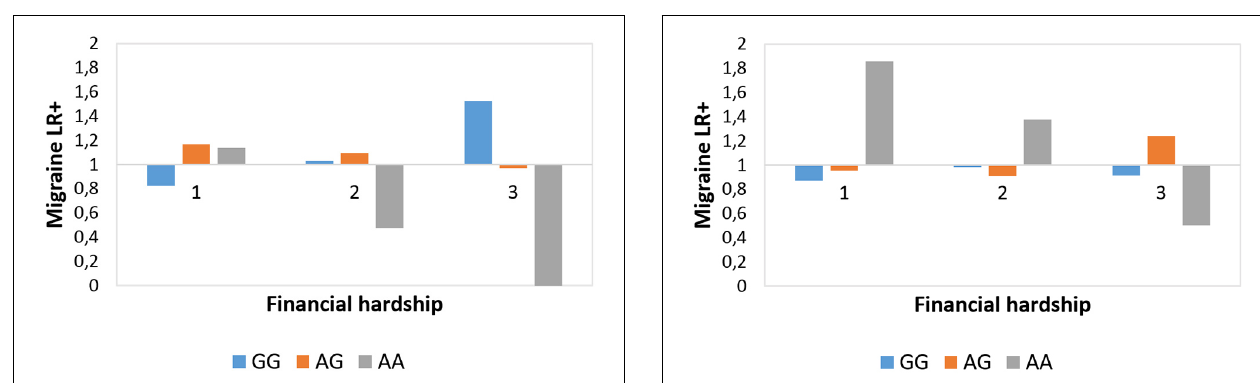
Table 3 shows the statistical results of interaction effects between CLOCK rs10462028 and financial hardship on migraineID in the subsamples separately (Manchester and Budapest)—to test the replicability of the significant SNP × FINANC effect found in the total sample. SNP, single nucleotide polymorphism; FINANC, financial hardship; OR, odds ratio;